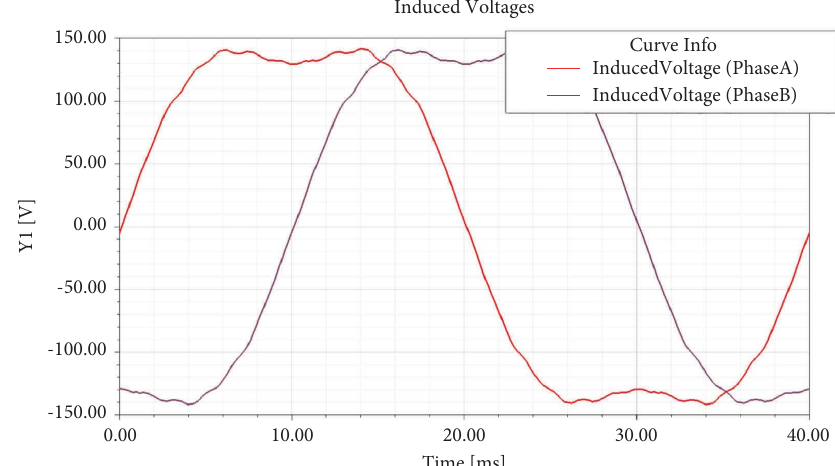
Figure 20: Back EMF curve of 2-pole 24-slot motor.